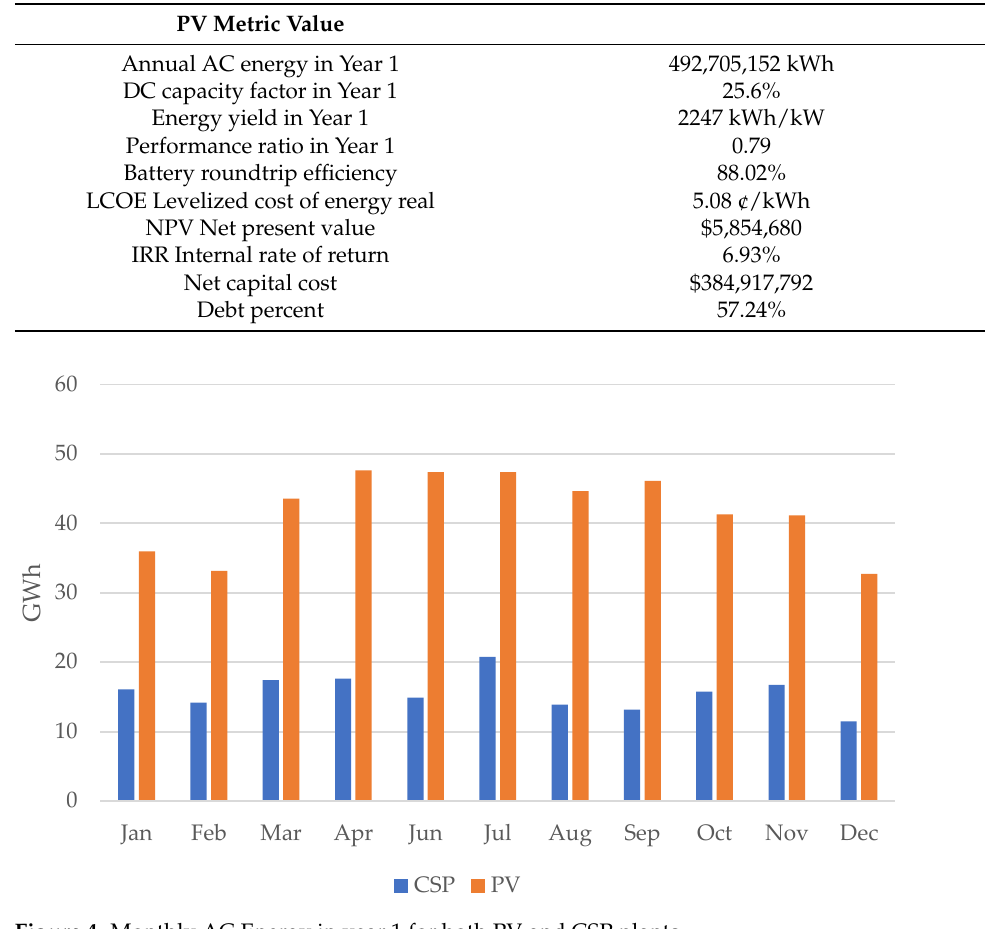
Table 7. PV plan SAM model summary metric values.